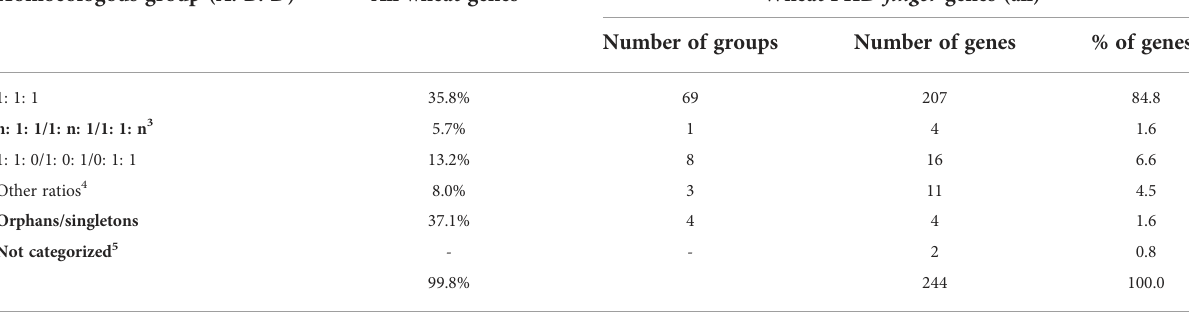
TABLE 2 Groups of homoeologous PHD- fi nger genes in wheat. Homoeologous group (A: B: